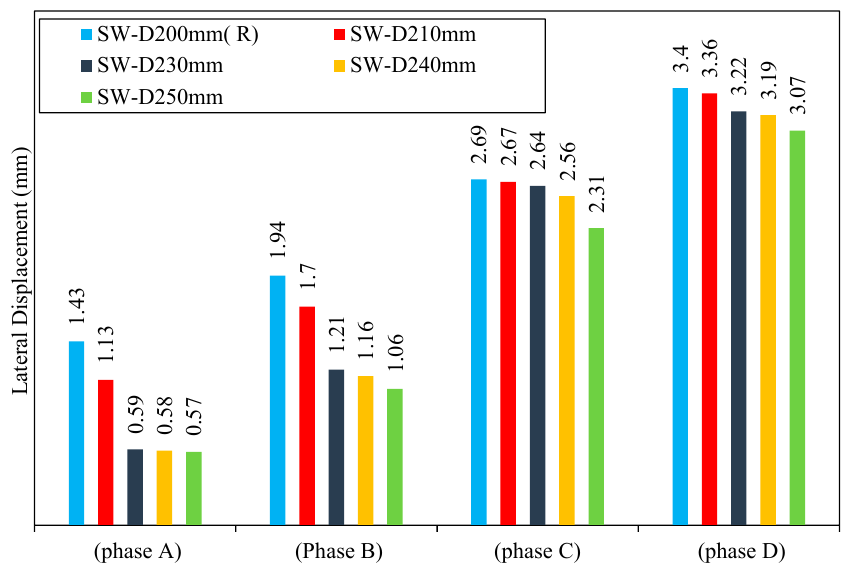
Figure 24. Lateral displacement of group 4.